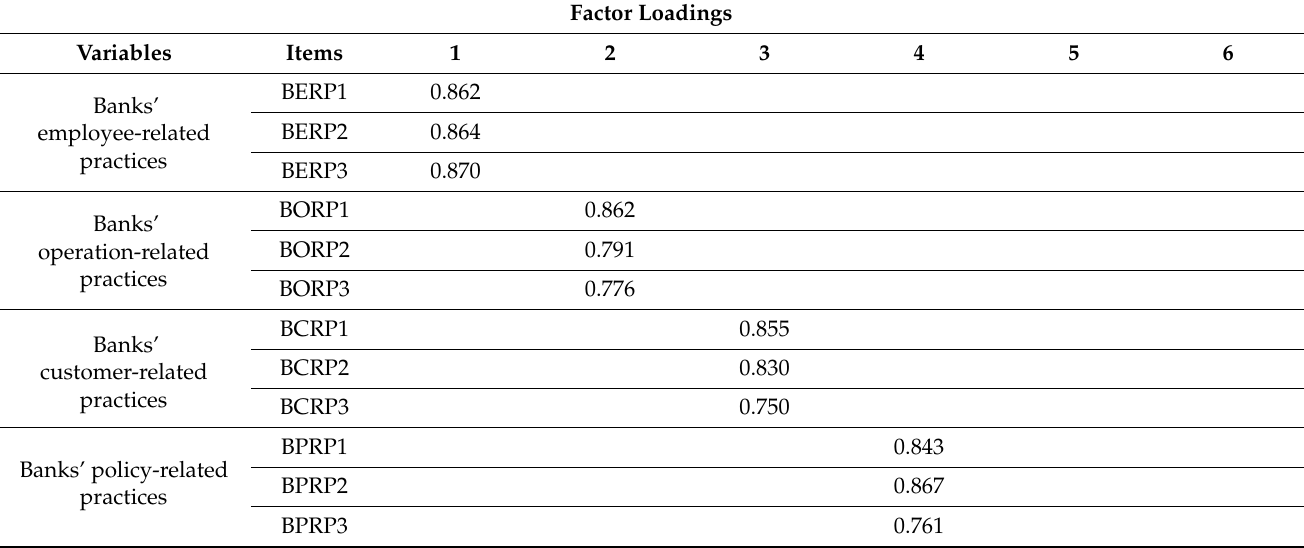
Table 4. Model estimates and factor extraction outcomes of the